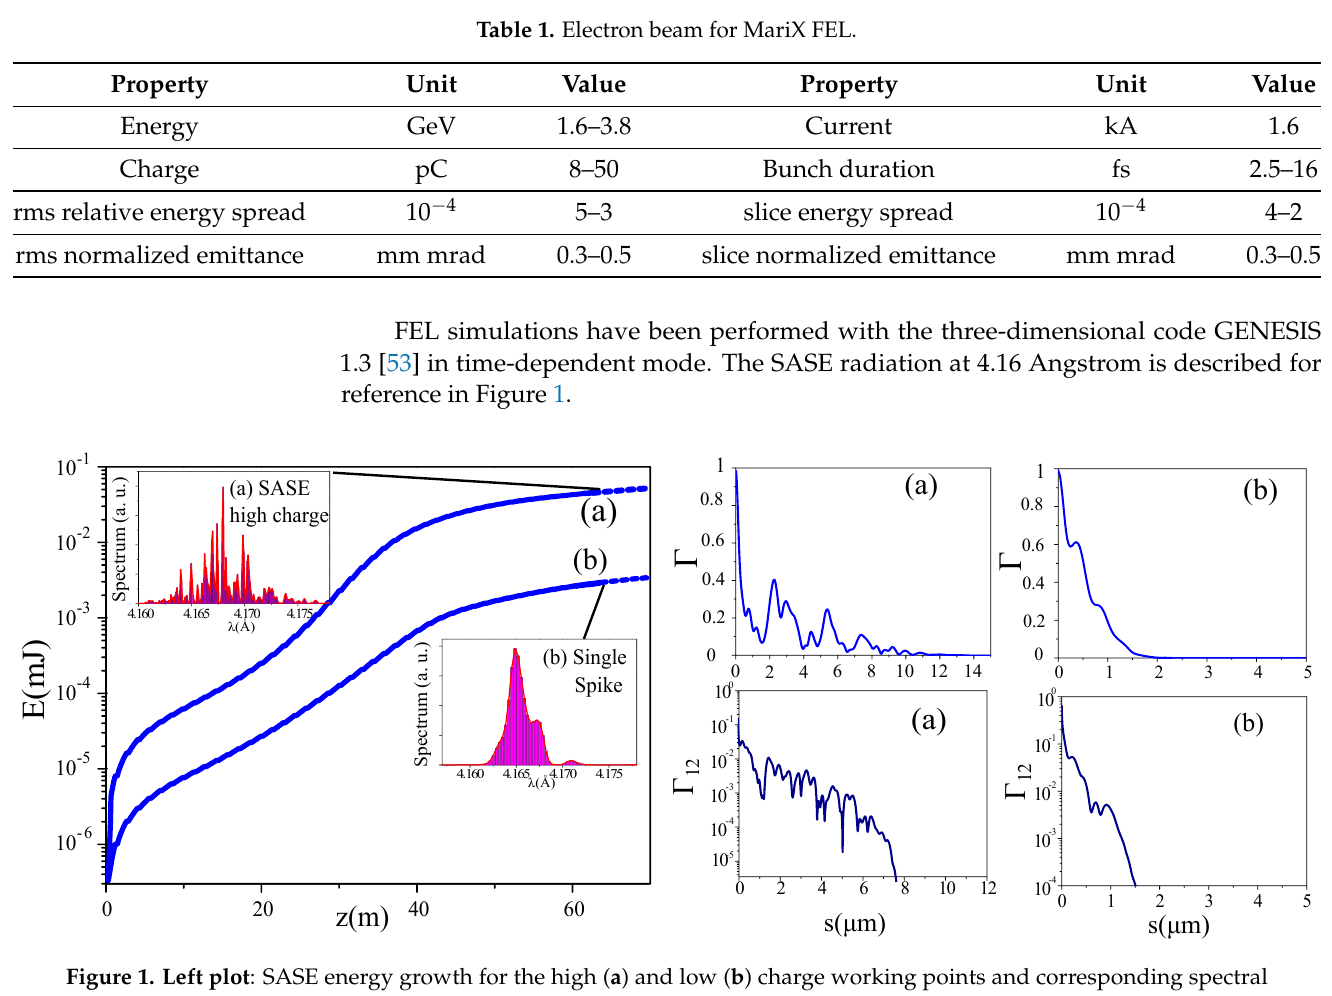
Figure 1. Left plot : SASE energy growth for the high ( a ) and low ( b ) charge working points and corresponding spectral profiles at saturation (inner boxes). Right windows : self ( Γ , upper row) and mutual ( Γ 1,2 , lower row) coherence degrees vs. s = c τ for the two analyzed working points ( a ) and ( b